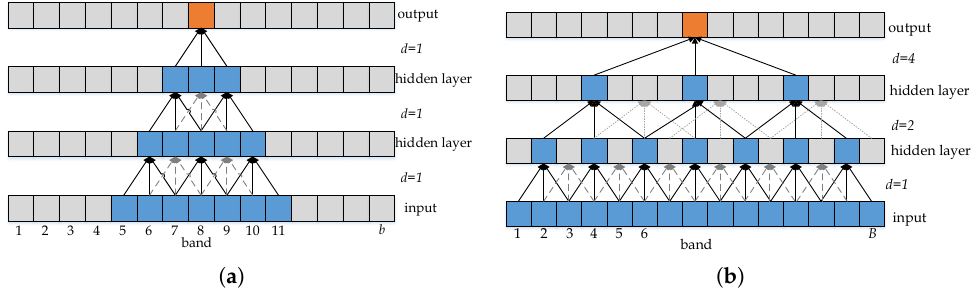
Figure 1. ( a ) An example of standard spectral convolution, and ( b ) An example of dilated spectral convolution, where the receptive field is much larger with just few